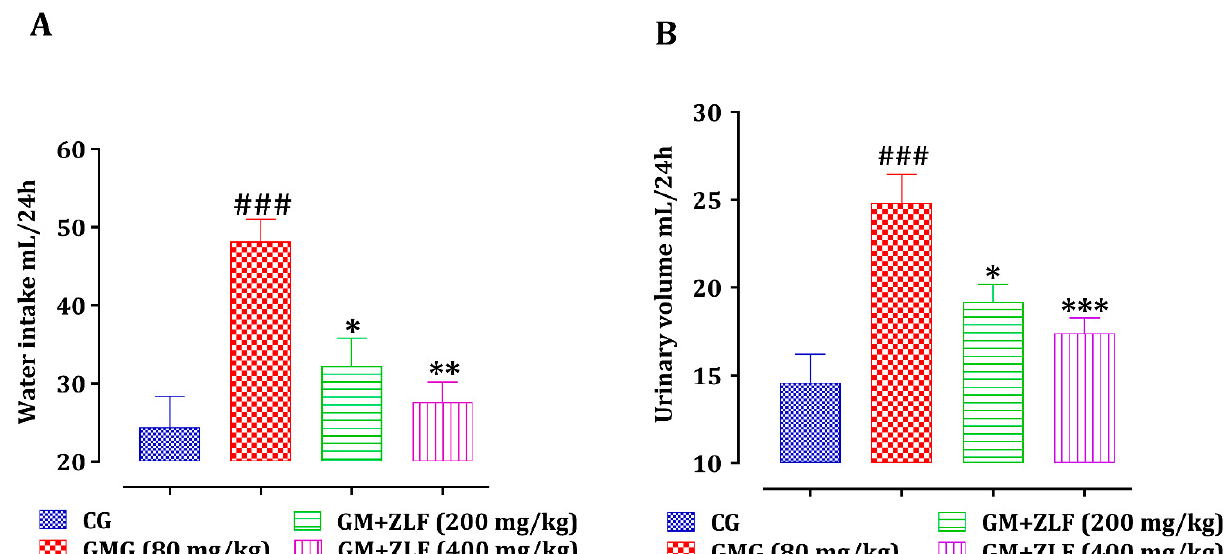
Figure 2. Effect of ZLF’s on intake of water ( A ) and the volume of urine ( B ) in GM-poisoned rats. The data are presented as mean ± SEM, ( n = 6). ### p ≤ 0.001 against the CG. * p < 0.05, ** p < 0.01, *** p < 0.001 against GMG. GM: gentamicin; CG: Control Group; GMG: GM treated Group.